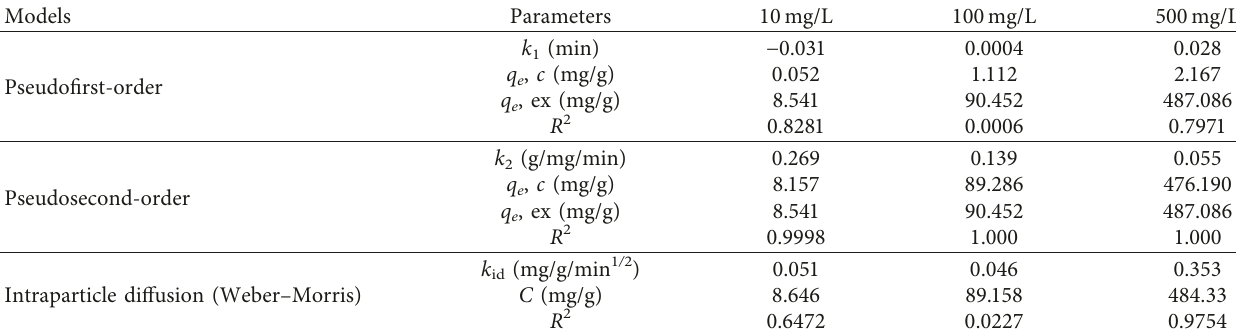
Figure 4: Influence of process parameters (a) contact time, (b) pH, (c) DNL dose, and (d) temperature. Table 4: Kinetic parameters for Co(II) adsorption on